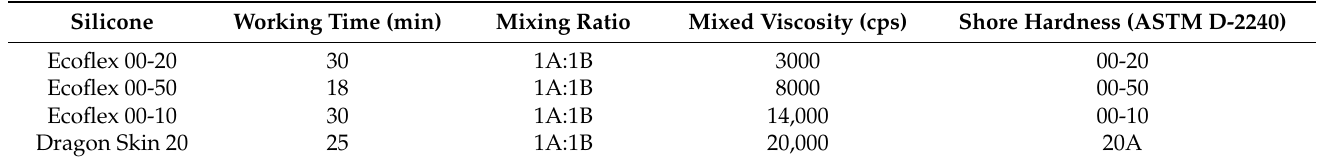
Table 1. Properties of the silicones used in this